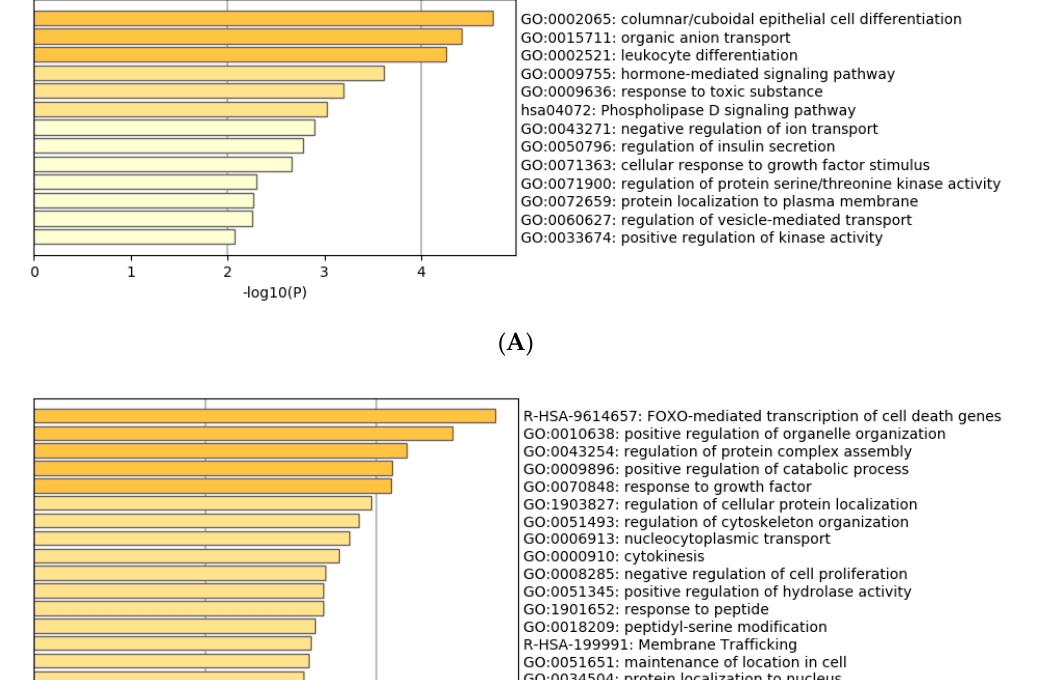
Figure 4. Analysis of the functional enrichment of target genes. ( A , B ) The main enrichment analysis clusters detected by Metascape of genes associated with upregulated miRNA after treatment with OMVs; ( C ) interaction network of the clusters detected by Metascape. The nodes of the same colour belong to the same cluster. Terms with a similarity score > 0.3 are linked by an edge. The network is visualized with Cytoscape (v3.1.2) with a “force-directed” layout and edge bundled for clarity.